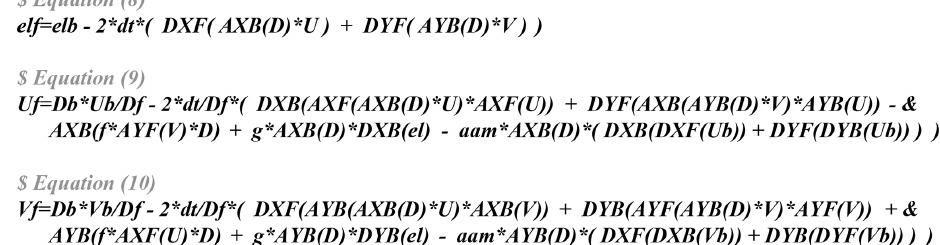
Figure 3. Implementation of the shallow water equations by basic operators. elf, el, and elb denote sea surface elevations at times ( t + 1), t , and ( t − 1), respectively. Uf, U and Ub denote the zonal velocity at times ( t + 1), t , and ( t − 1), respectively. Vf, V , and Vb denote the meridional velocity at times ( t + 1), t , and ( t − 1), respectively. Variable aam denotes the viscosity coefficient.